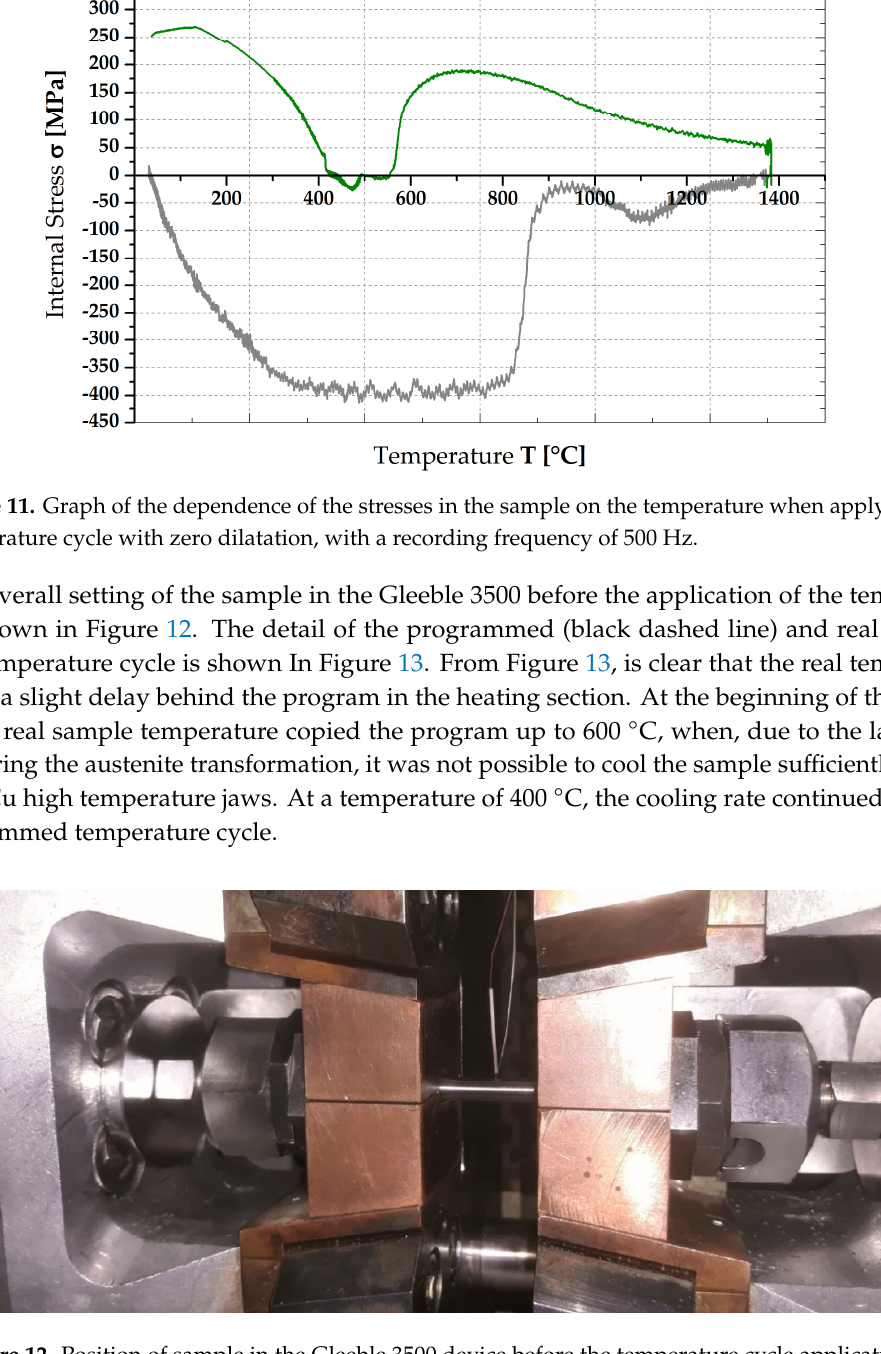
Figure 12. Position of sample in the Gleeble 3500 device before the temperature cycle application.